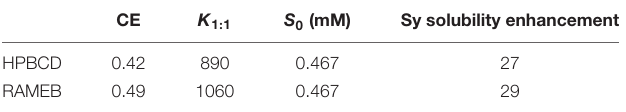
TABLE 2 | Complexation efficiency (CE), stability constant of 1:1 complex of silymarin formed with HPBCD and RAMEB ( K 1 : 1 ) and improvement of dissolution calculated from the phase-solubility curves of silymarin complexed with HPBCD and RAMEB.